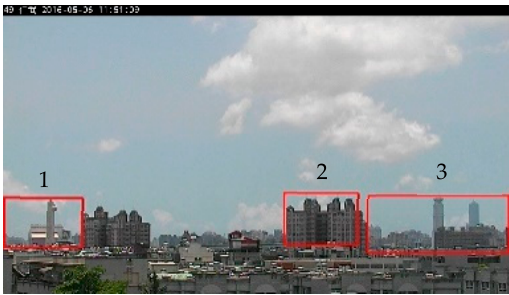
Figure 9. The three candidate regions of interest indicated by red boxes.